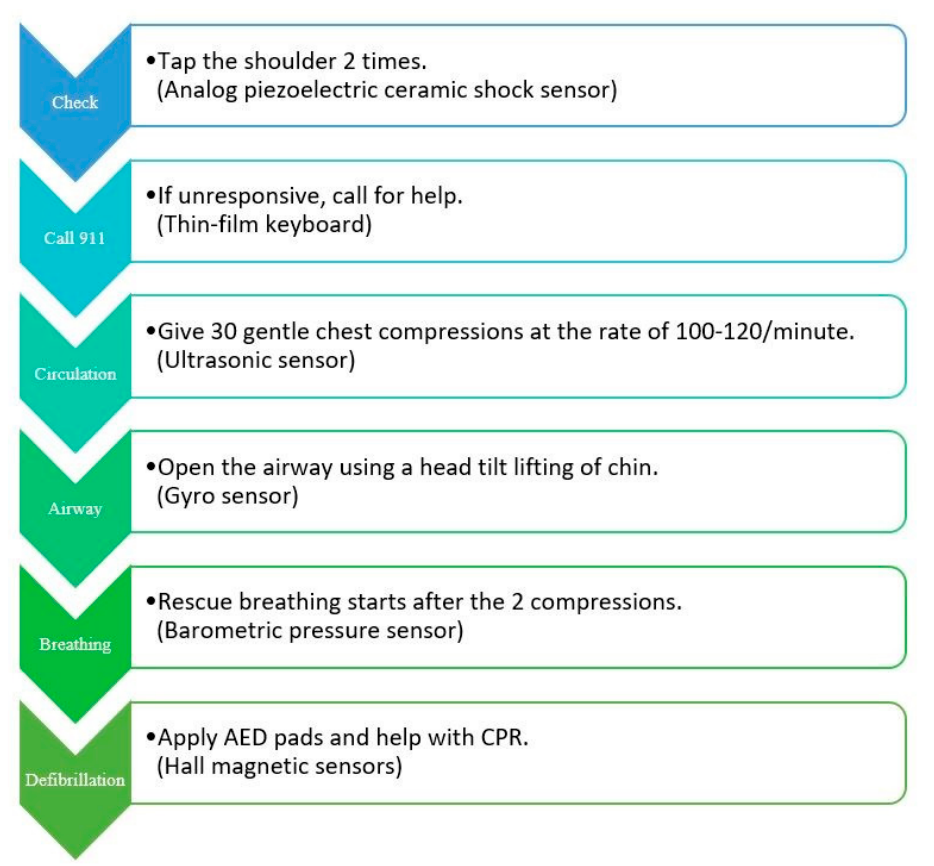
Figure 12. The CPR steps and their corresponding